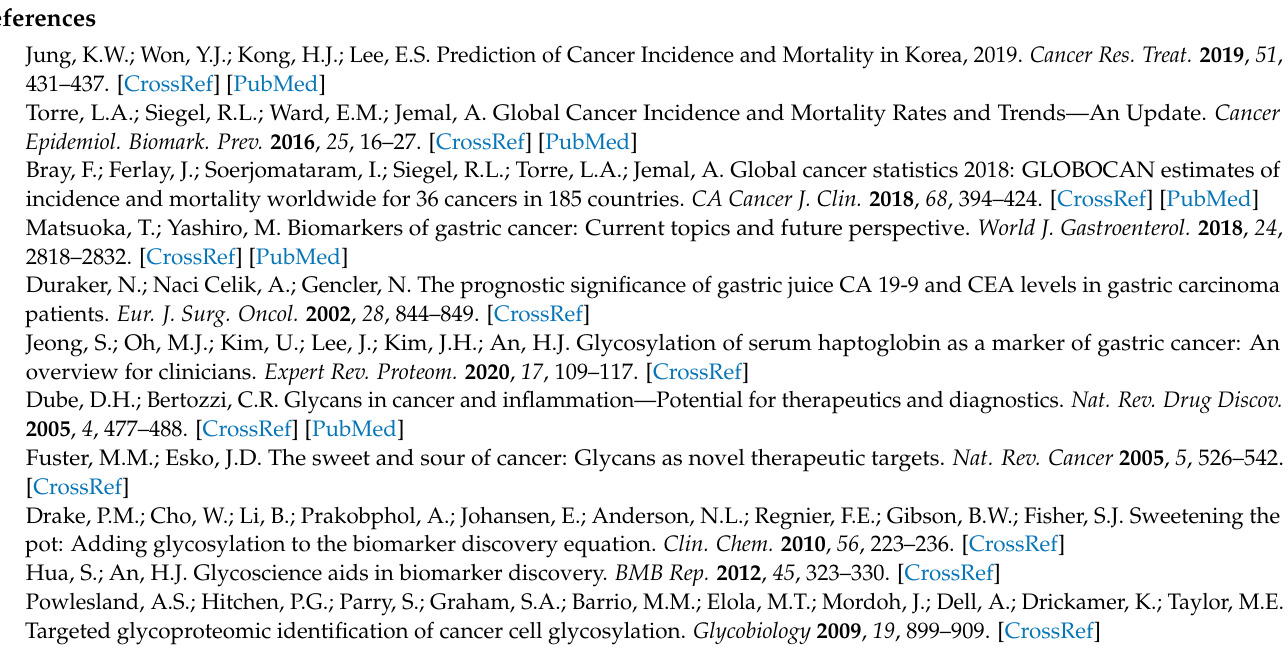
GP3, Table S1: Clinical information of samples involved in this study, Table S2: The list of 41 N- glycans of haptoglobin used for construction of in-silico glycopeptide library, Table S3: The list of in silico haptoglobin glycopeptide library, Table S4: A complete list of glycopeptides found in serum